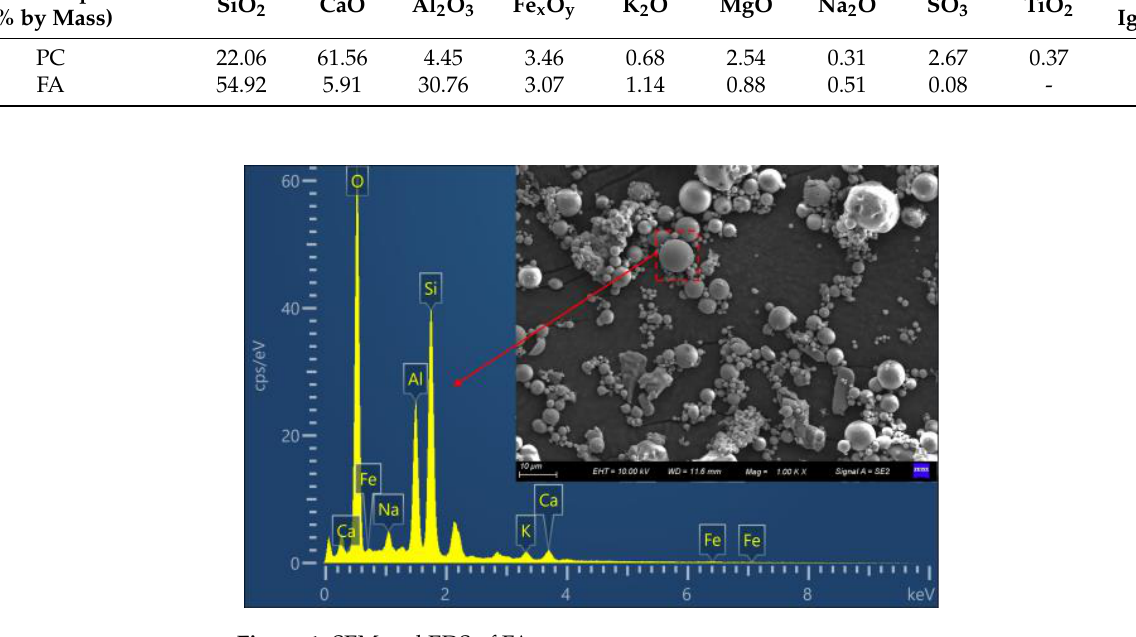
Figure 1. SEM and EDS of FA.